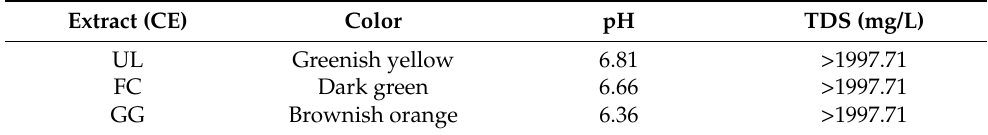
Table 3. Crude extracts (CEs) stock solution from seaweed samples observing their color and analyz- ing their pH from the, U. lactuca (UL), F. ceranoides (FC) and Gracilaria gracilis (GG) seaweed